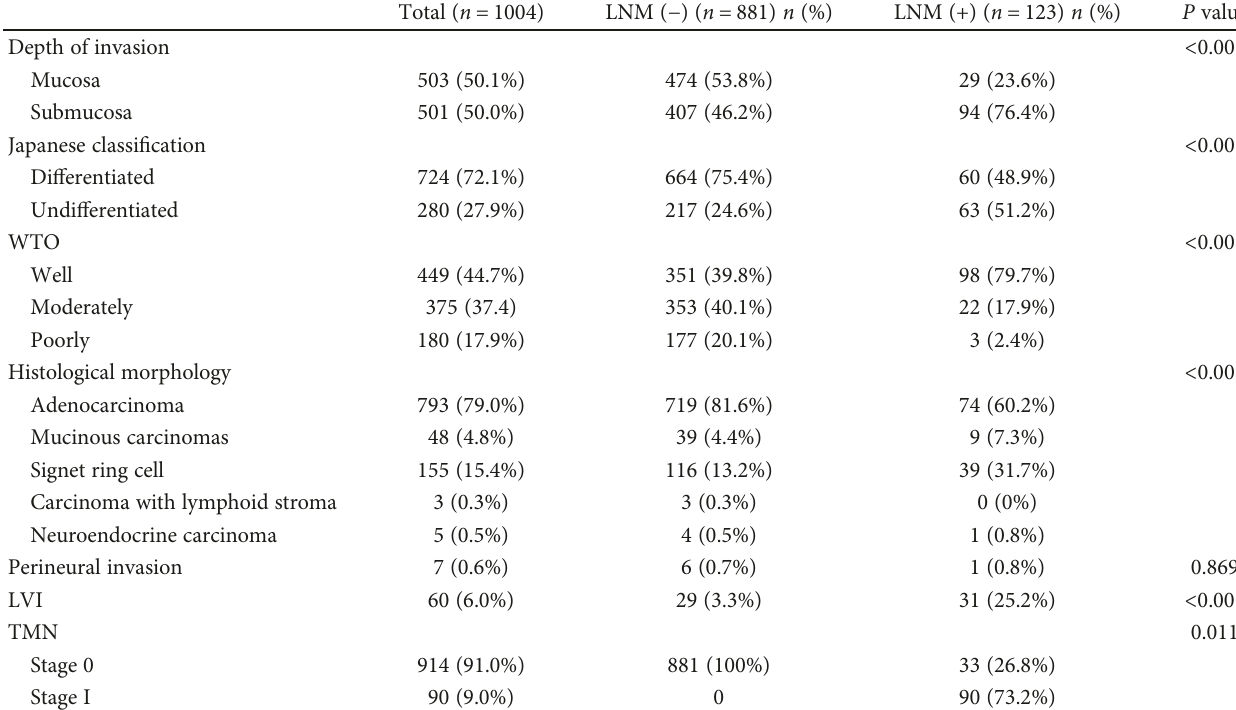
Table 3: Pathological features of the included patients.